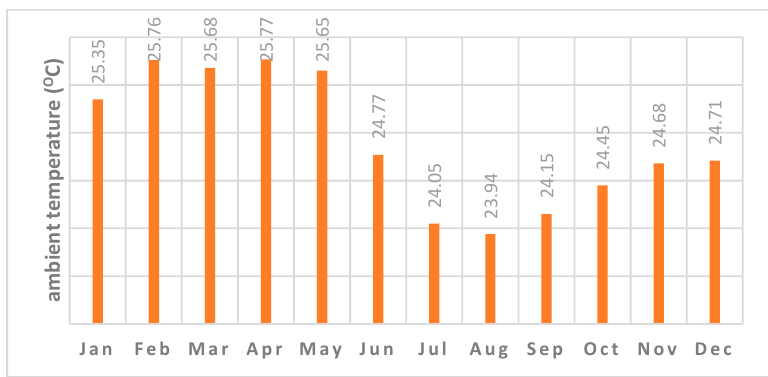
Figure 5. Monthly average ambient temperature for the village of Mboke.